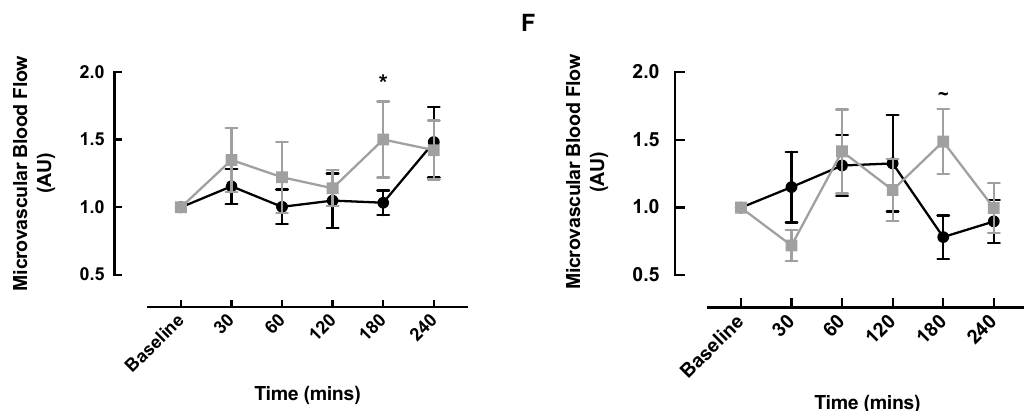
Figure 2. The impact of curcumin alongside oral nutritional supplement feeding on microvascular blood volume ( A , D ), microvascular flow velocity ( B , E ), and microvascular blood flow ( C , F ) in the m. vastus lateralis ( A – C ) and m. tibialis anterior ( D – F ) of healthy older adults. A ~ denotes a significant difference between groups ( p < 0.05); ˆ denotes significant difference from control baseline ( p < 0.05); * denotes significant difference from curcumin baseline ( p < 0.05).